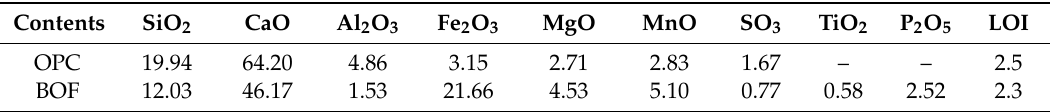
Table 1. Chemical composition and loss on the ignition results (wt.%) of the basic oxygen steelmaking slag (BOF) and ordinary Portland cement